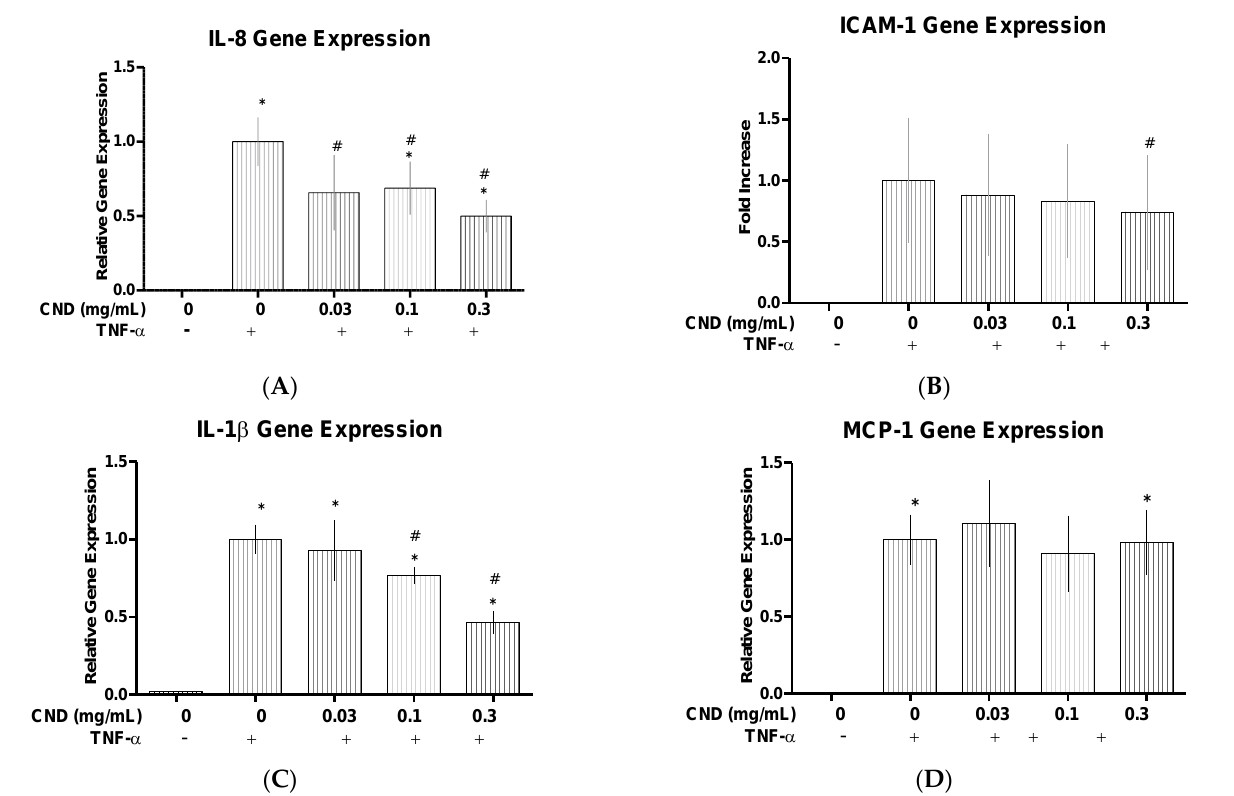
Figure 3. qRT-PCR proinflammatory gene expression. HMEC-1 cells underwent treatment with 10 ng/mL of TNF-α as indicated with the presence or absence of 0.03, 0.1, or 0.3 mg/mL of CNDs for 6 h. After treatment, cells underwent RNA extraction, cDNA synthesis, and qRT-PCR. ( A ) IL-8, ( B ) ICAM, ( C ) IL-1β, ( D ) MCP-1. A significant change was demonstrated during analysis of gene expression. All data represent mean ± SEM. (n = 3–6, * p < 0.05 vs. control, # p < 0.05 vs. TNF- α ).